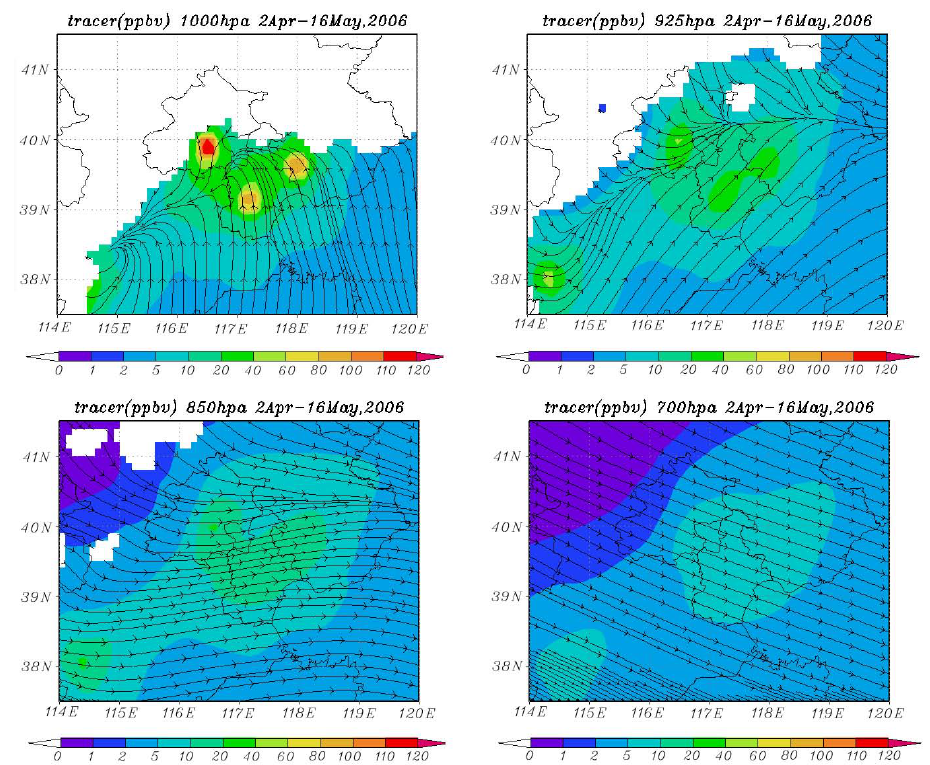
Fig. 2. Model simulated wind fields and spatial distributions of pollution tracers emitted from major urban centers of Huabei. Mountain areas are masked by blanks. The model predicts an air pollution pool over the larger Beijing, Tianjin and Tangshan area (Jing-Jin-Tang).